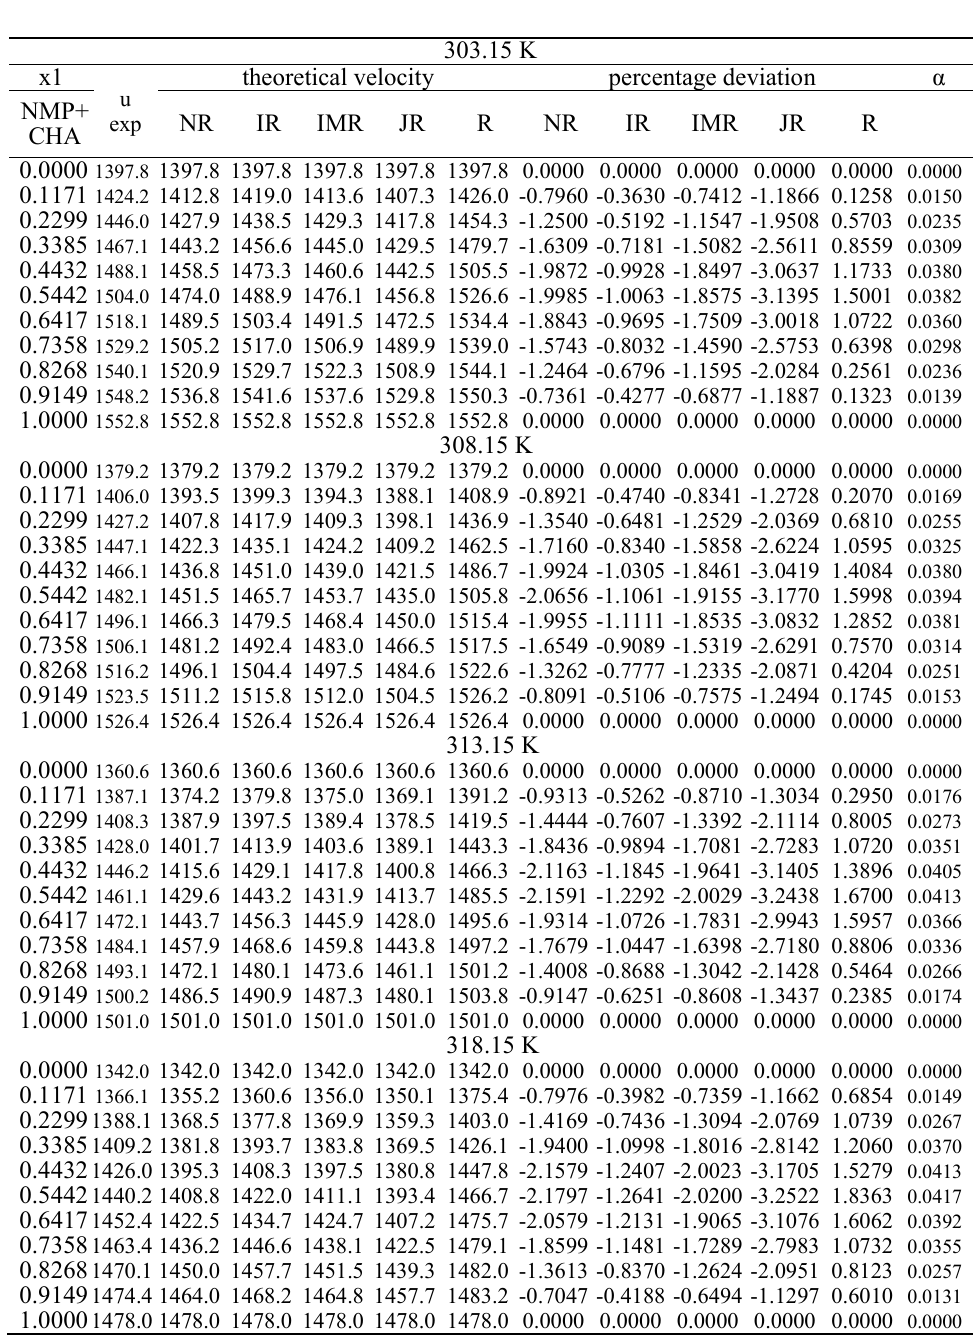
Table 1. The experimental velocity(U), the theoretical velocity, percentage deviation and molecular interaction parameter (α) for the system N -Methyl-2-pyrrolidone with cyclohexylamine ay different